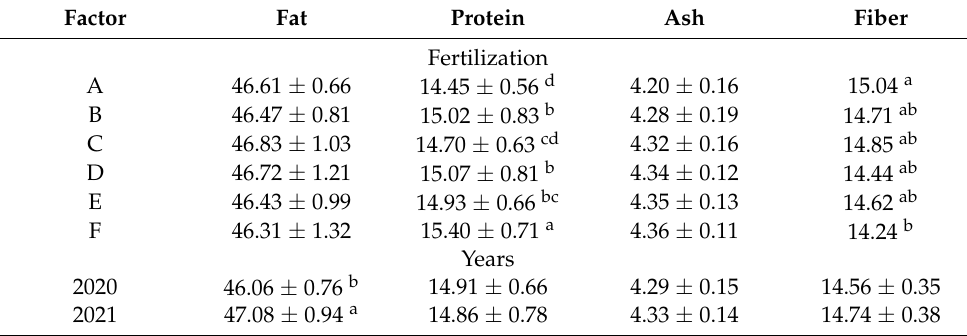
Table 5. Chemical composition of achenes in % DM.